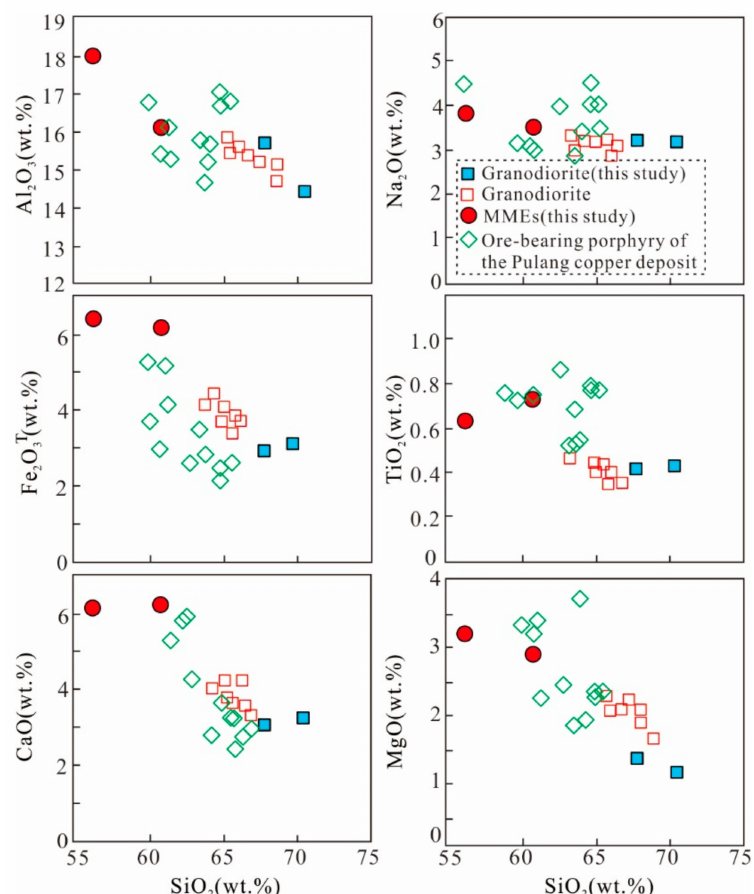
Figure 4. Harker diagrams for granodiorite and MMEs. Note: The data for granodiorite from [17,18] and the data for ore-bearing porphyry of the Pulang copper deposit from [10].